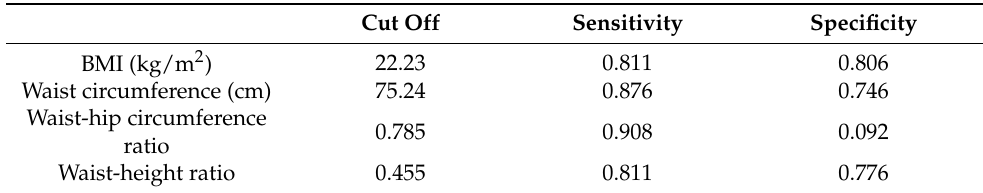
Table 5. Optimal cut-off values for different metabolic indices, and their sensitivities and specificities for hypertension.